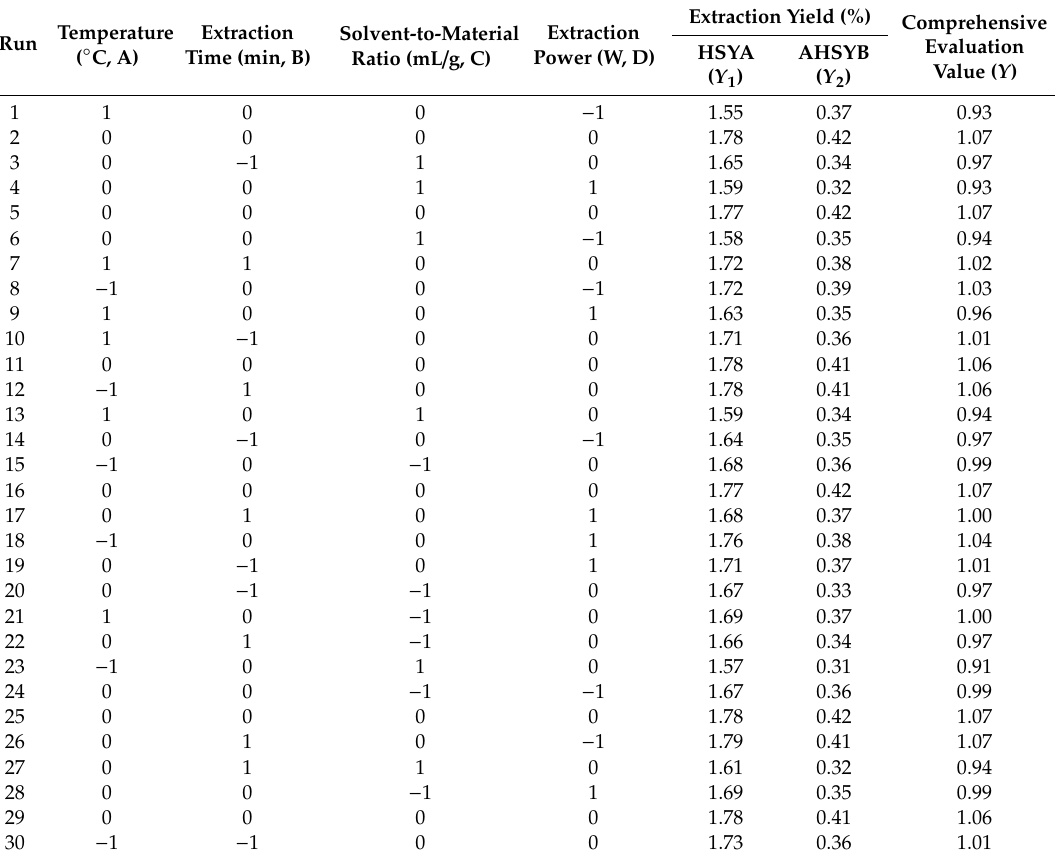
Table 5. Box–Behnken design (BBD) for the independent variables and corresponding response values. Temperature Extraction Solvent-to-Material Run ( ◦ C, A) Time (min, B) Ratio (mL / g,